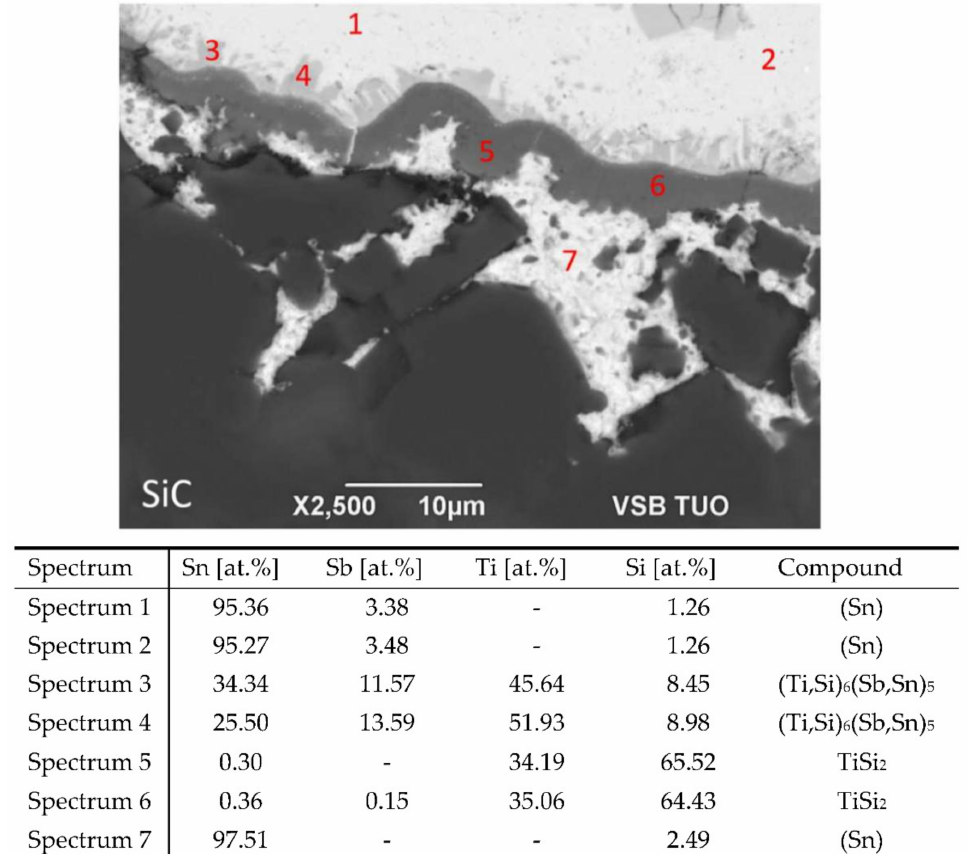
Figure 10. Point EDX analysis of solder from SiC/Sn5Sb3Ti joint boundary of the specimen for wettability